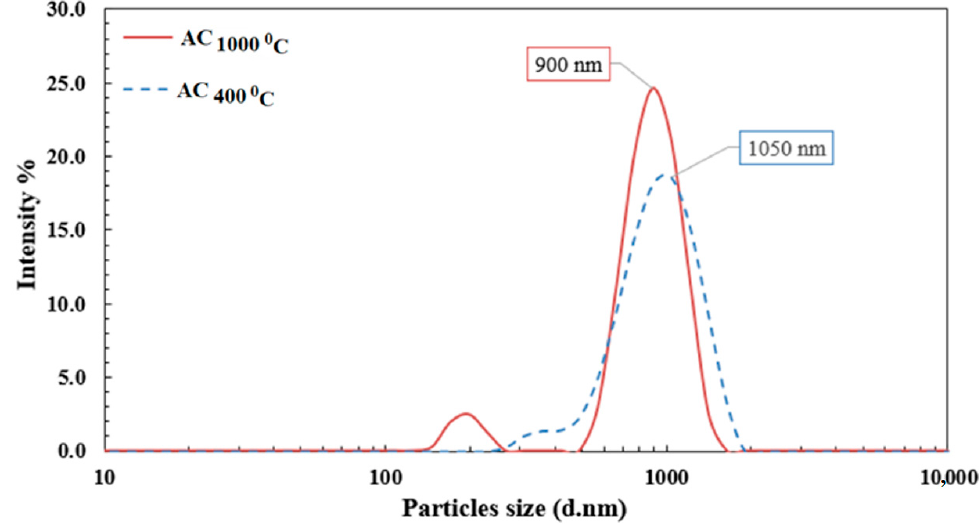
Figure 3. Particle-size-distribution analysis for activated carob